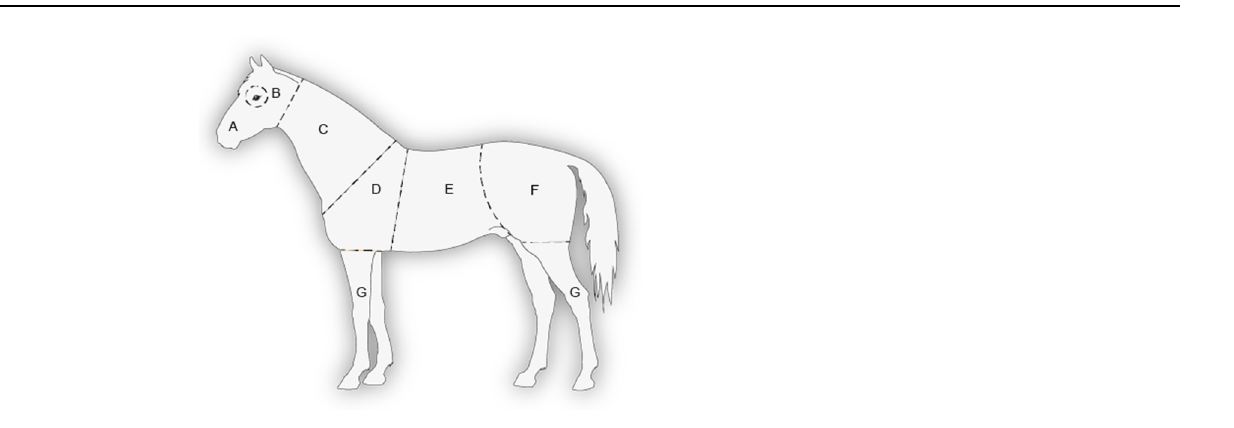
Figure 4. Horse body sketch used to record the location of the injuries, adapted from [34,36,37]. The letters correspond to the following body areas: A—Head; B—Eyes; C—Neck; D—Shoulders; E—Barrel; F—Rump; G—Legs.